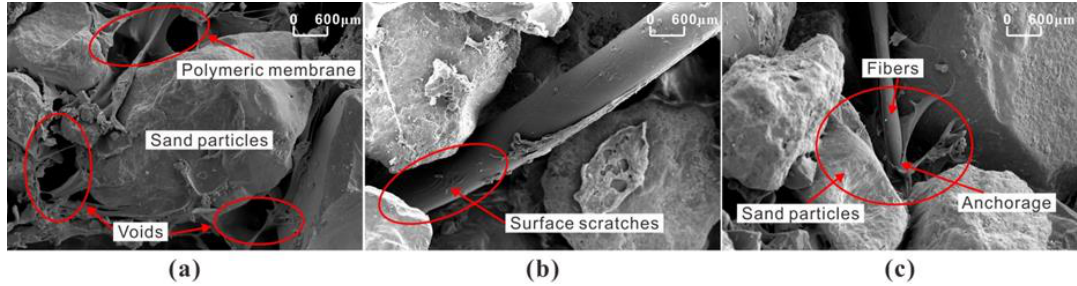
Figure 14. SEM images of 200 times magnification: ( a ) space network structure; ( b ) fiber surface scratches; and ( c ) anchorage effects.